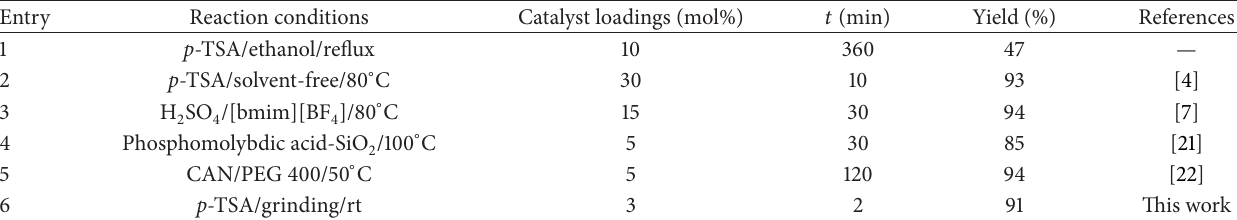
Table 3: Comparison study with reported